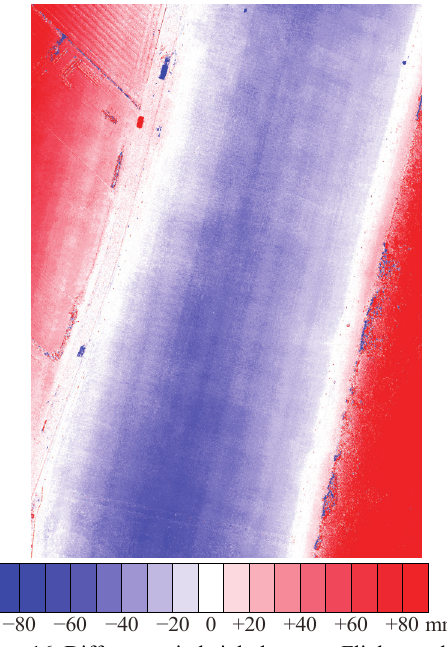
Figure 16. Differences in height between Flight number 1 by QC730 and Flight number 4 by Phantom 4